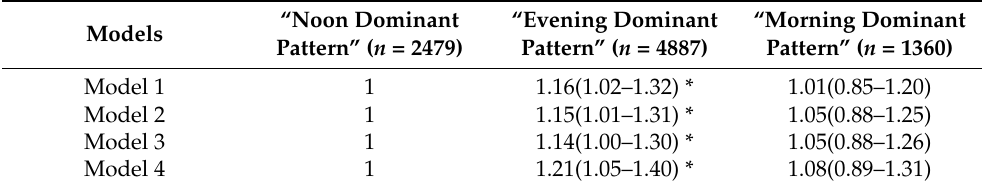
Table 5. Association between time-of-day energy intake patterns and insulin resistance (OR, 95% CI) 1